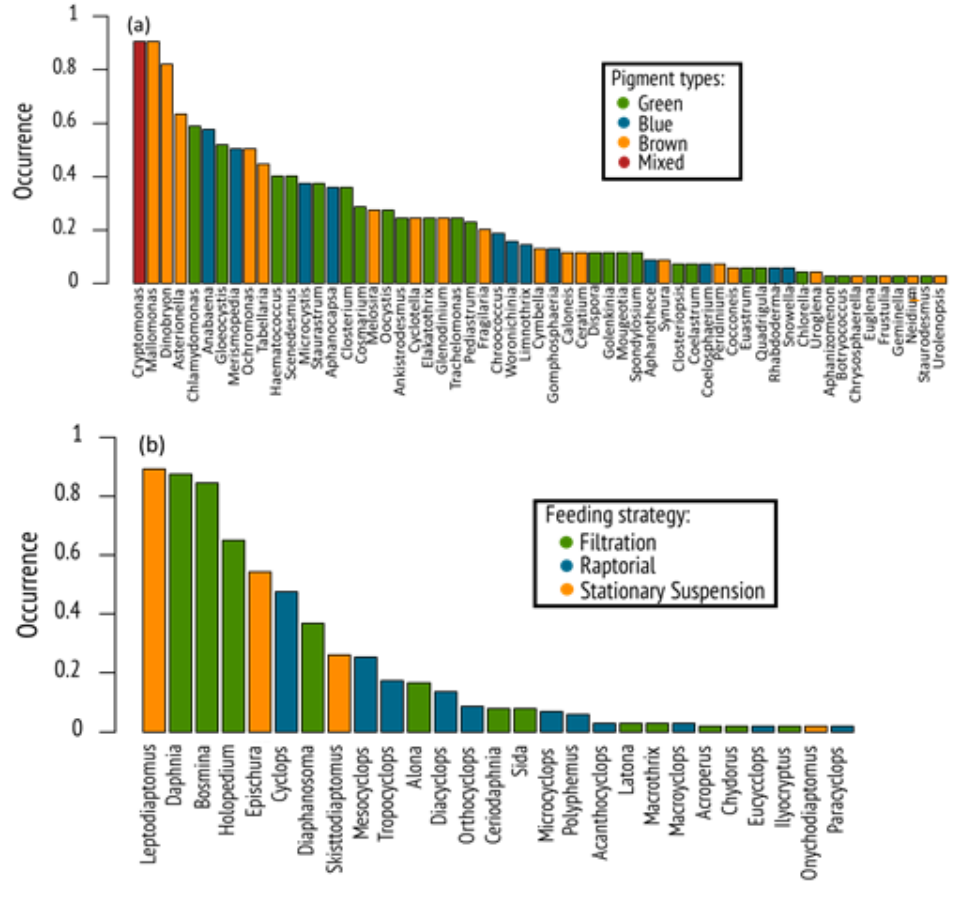
Figure 3: Ranked occurrence (percent of all lakes) of (a) phytoplankton and (b) zooplankton taxa.Bars and dots were coloured by Pigment trait type for phytoplankton and the Feeding strategy trait for